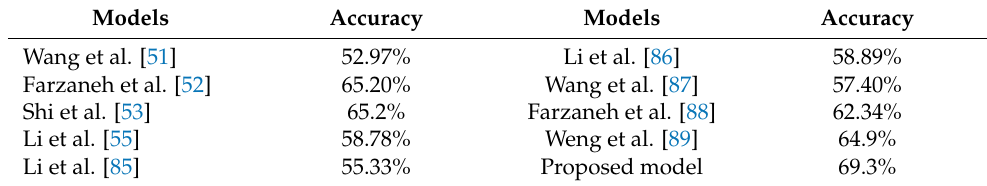
Table 4. Comparison of facial emotion recognition model performance on the AffectNet dataset.